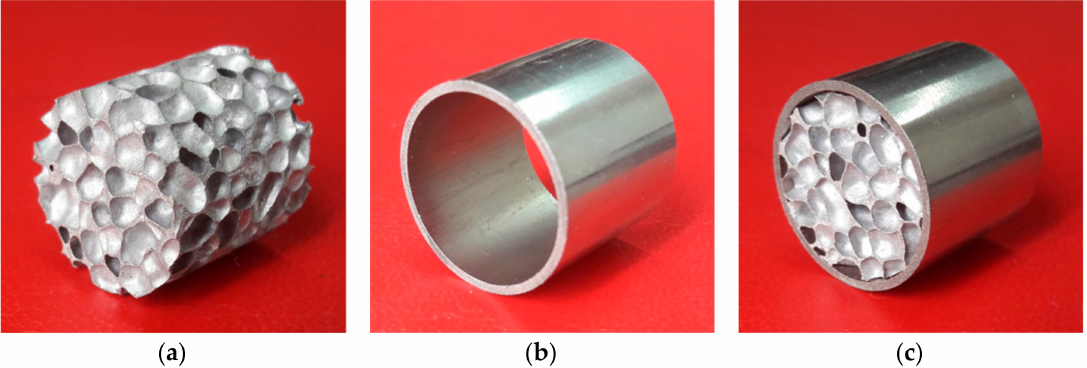
Figure 1. Samples configurations: aluminum foam ( a ); empty tube ( b ); and foam-filled tube ( c